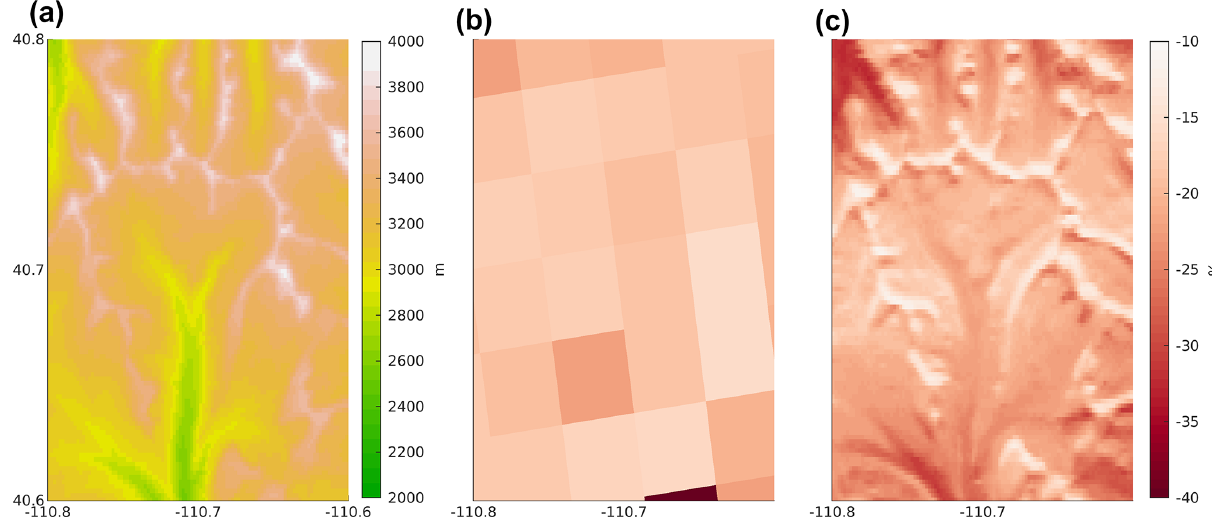
Figure 7. Example of simulations of changing maxswe for a portion of the Uinta Mountains, Utah (location is marked in Fig. 6). The elevation (m) of the domain is shown in (a) . The percent change (%) in maxswe between historical and late 21st century periods as simulated by a 4km WRF product (Rasmussen and Liu, 2017) is shown in (b) , and the same metric but from the SnowClim dataset is shown in (c) .